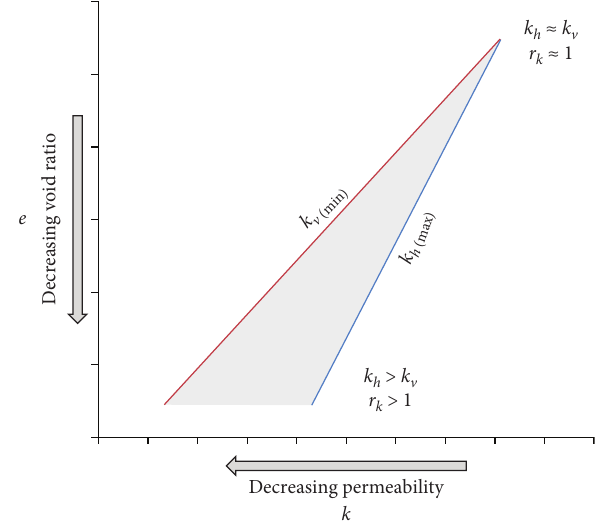
Figure 1: The k ( e ) graph showing a conceptual model of k and k v (min) variations and anisotropic permeability development for a given soil sample having a high void ratio during static one- dimensional